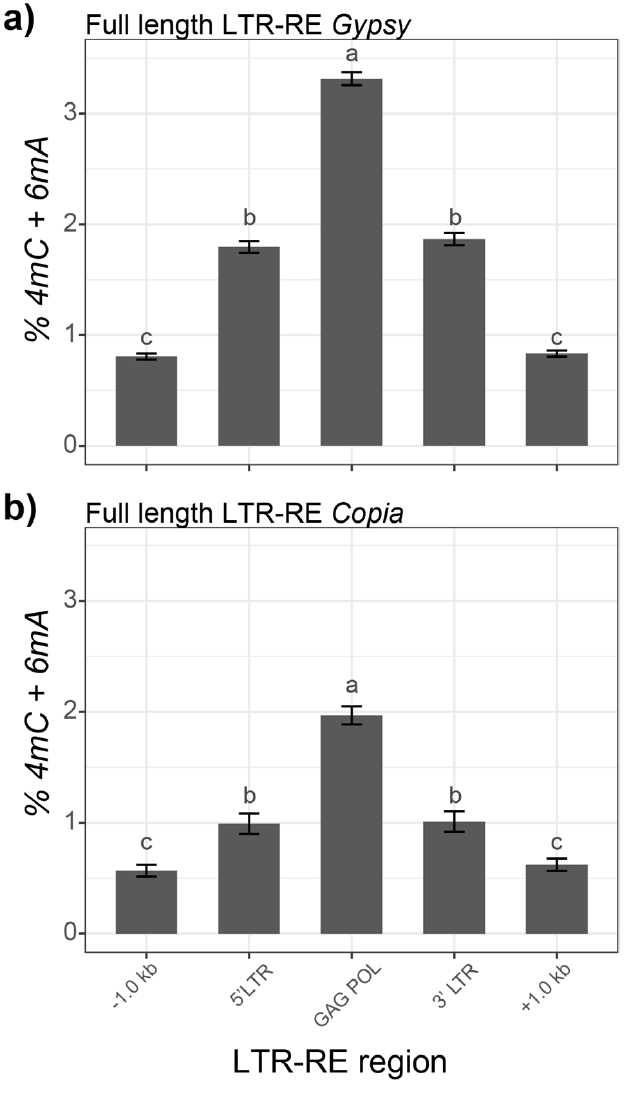
Figure 3. Percentages of 4mC and 6mA in full length Gypsy LTR-REs ( a ) and Copia LTR-REs ( b ), including a 1-kbp window upstream and downstream of the LTR sequences. The bars report, for each bin, the average of the modified nucleotide in the corresponding regions of the REs, with the standard error included as the error bar. The letters above each bar indicate the groups assigned by Tukey’s test ( p < 0.05).